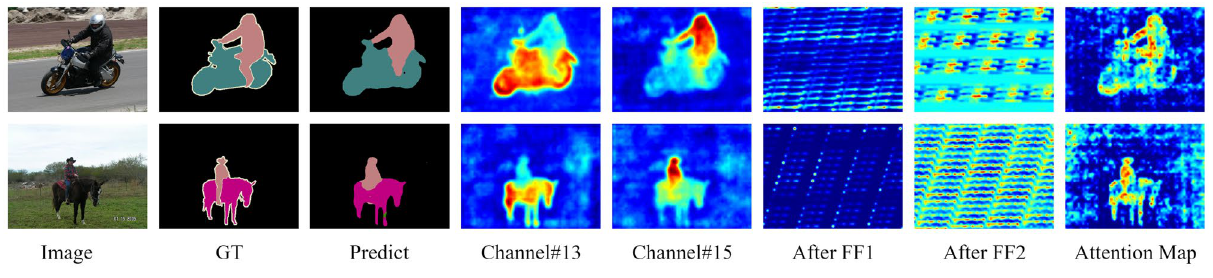
Figure 3. Visualization of PASCAL VOC 2012